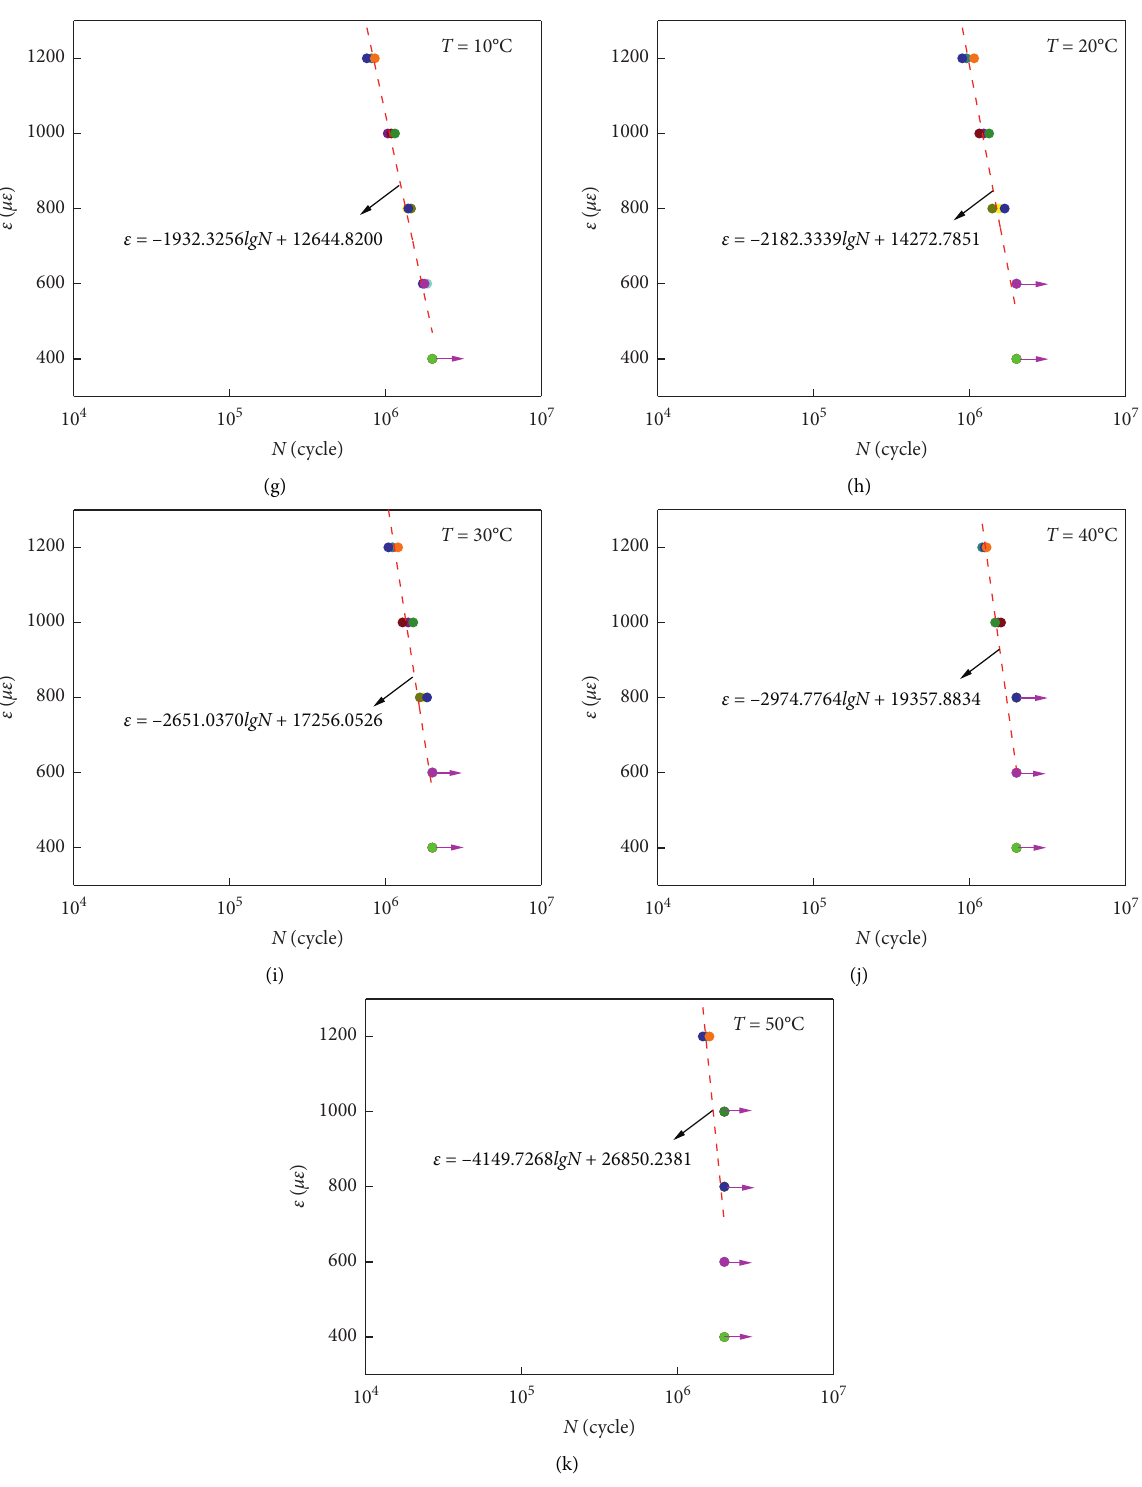
Figure 11: Fatigue life results and fitting curves at different temperatures: (a) T � − 50 ° C, (b) T �− 40 ° C, (c) T �− 30 ° C, (d) T �− 20 ° C, (e) T �− 10 ° C, (f) T � 0 ° C, (g) T � 10 ° C, (h) T � 20 ° C, (i) T � 30 ° C, (j) T � 40 ° C, and (k) T � 50 ° C. Note: the data points with symbol in the figure indicate that the fatigue life is greater than 2 × 10 6